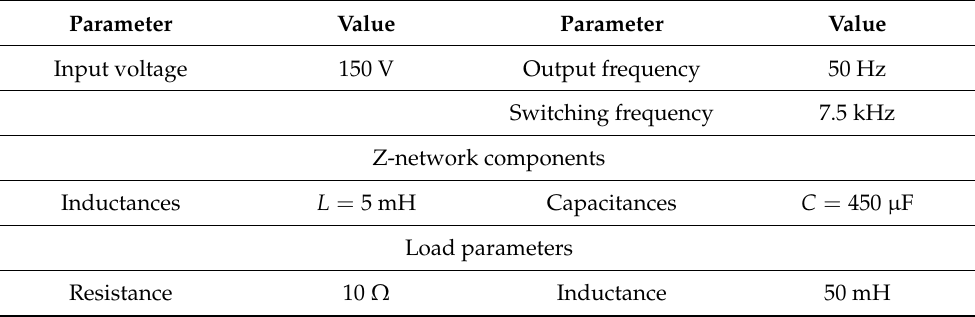
Table 5. Simulation Parameters.